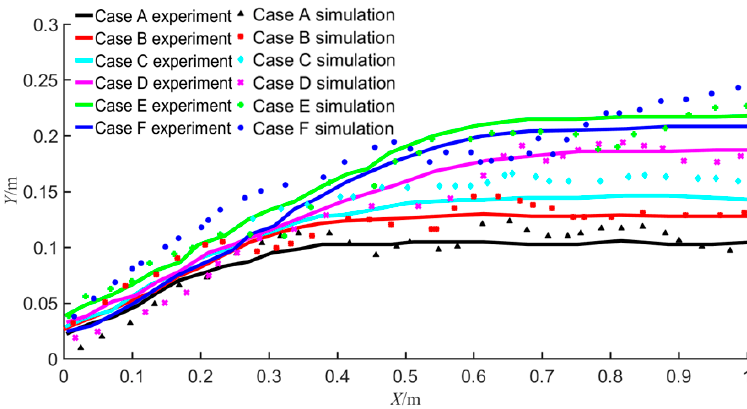
Figure 7. Wave profiles of Cases A to F. Table 3. Wave profiles comparison with the experimental data.